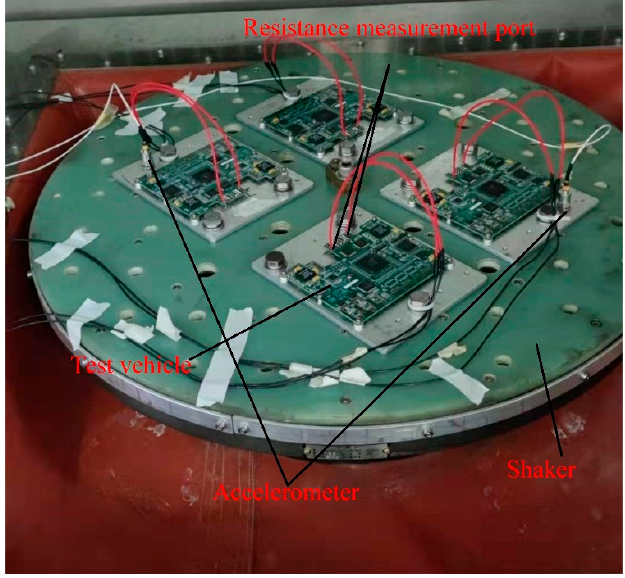
Figure 4. Experiment set-up of single random vibration and combined tests. Table 2. Instruments used in this paper.